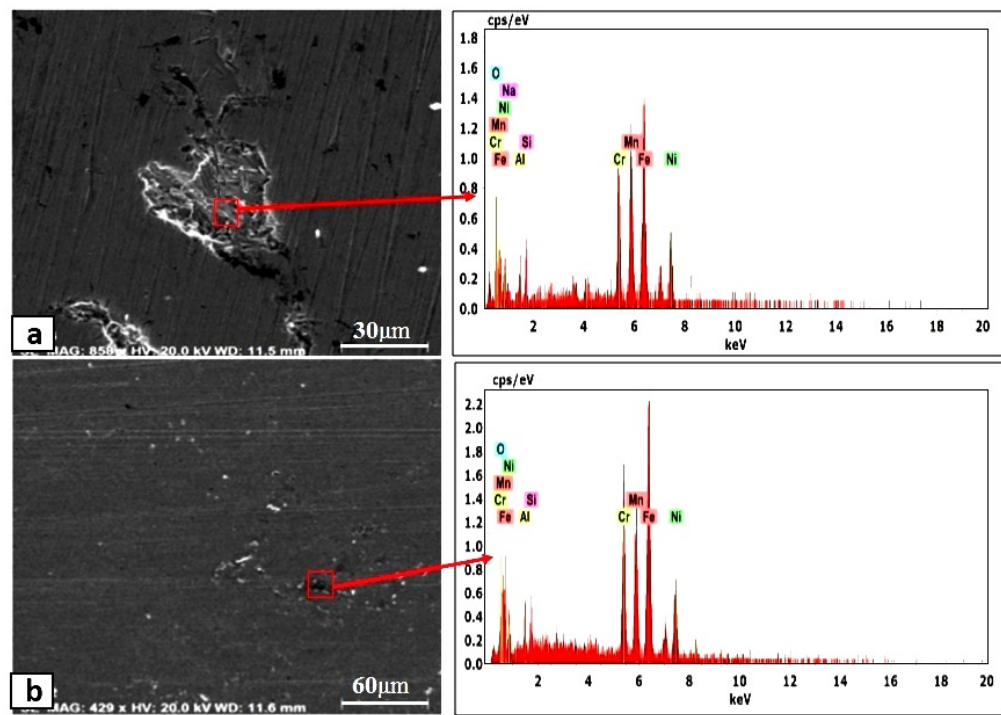
Figure 9. The EDX patterns of the corroded Fe 36 Mn 20 Ni 20 Cr 16 Al 5 Si 3 HEA in ( a ) cold-rolled and ( b ) solution-treated conditions in 0.6 M NaCl.